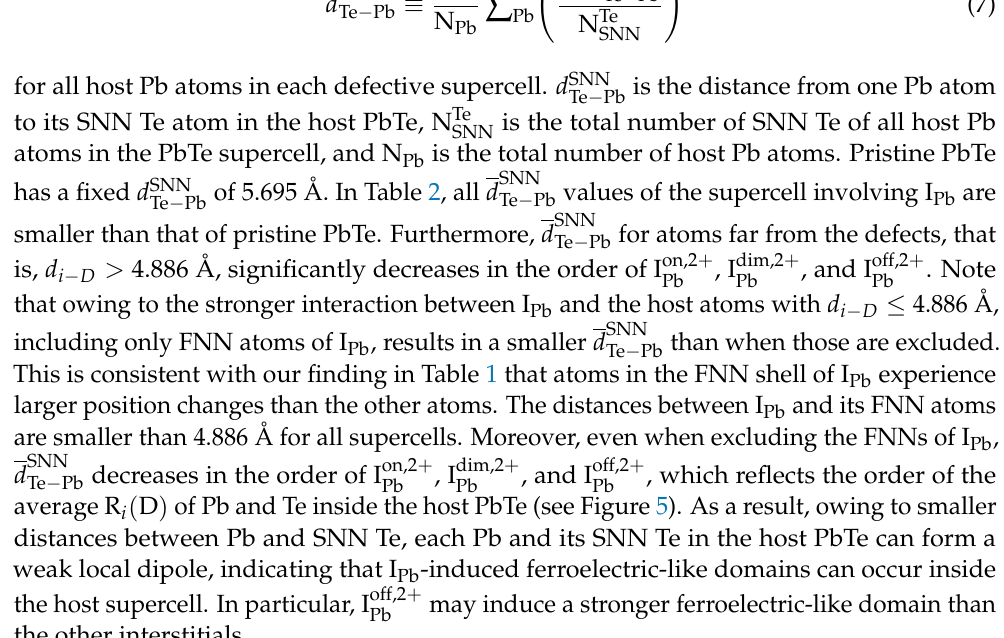
≤ 4.886 Å or > 4.886 Å in supercells with the Pb